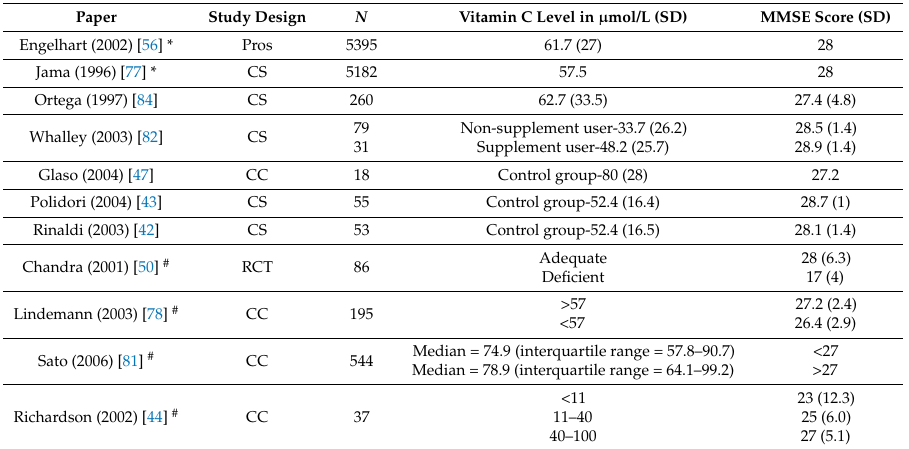
Table 5. Cognitively intact participants (Mean blood vitamin C/MMSE